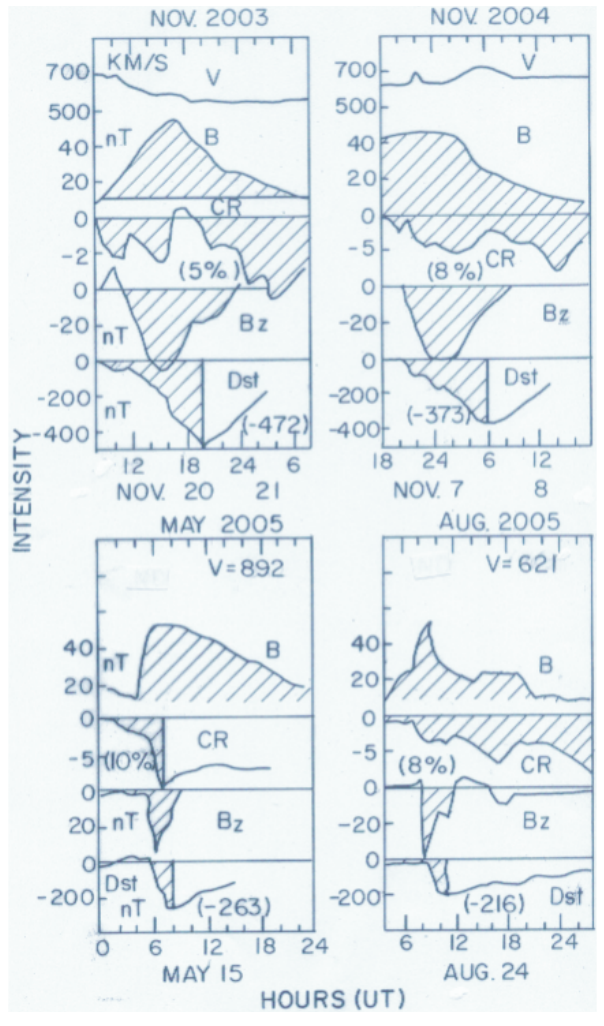
Fig. 4. Same as Fig. 1, for the four events, 20–21 November 2003, 7–8 November 2004, 15 May 2005 and 24 August 2005.